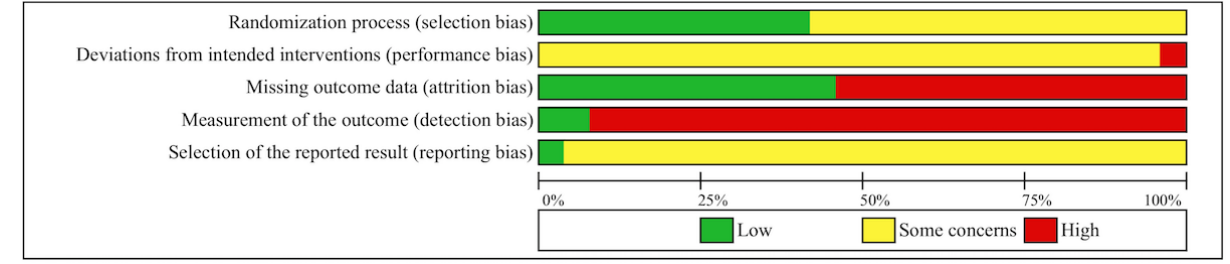
Figure 2. Risk of bias graph.